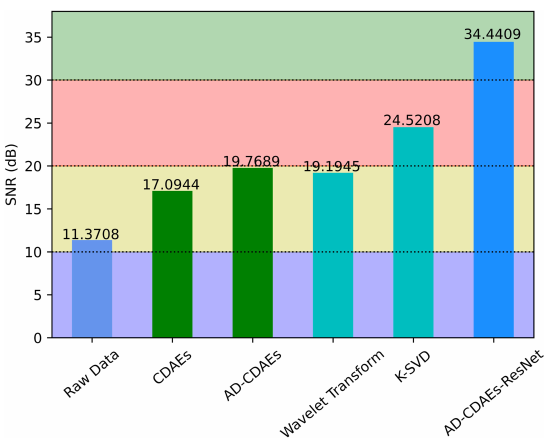
Figure 14. SNR histogram of various